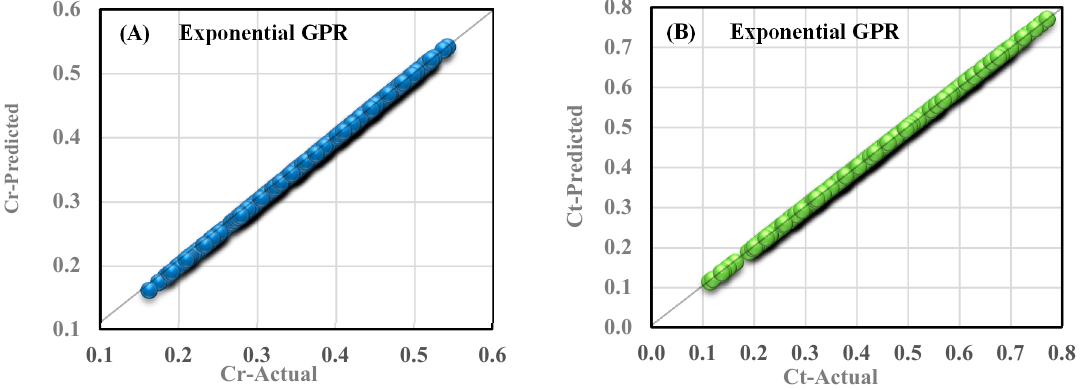
Figure 6. Measured versus predicted ( A ) Cr using exponential GPR ( B ) Ct using exponential GPR.